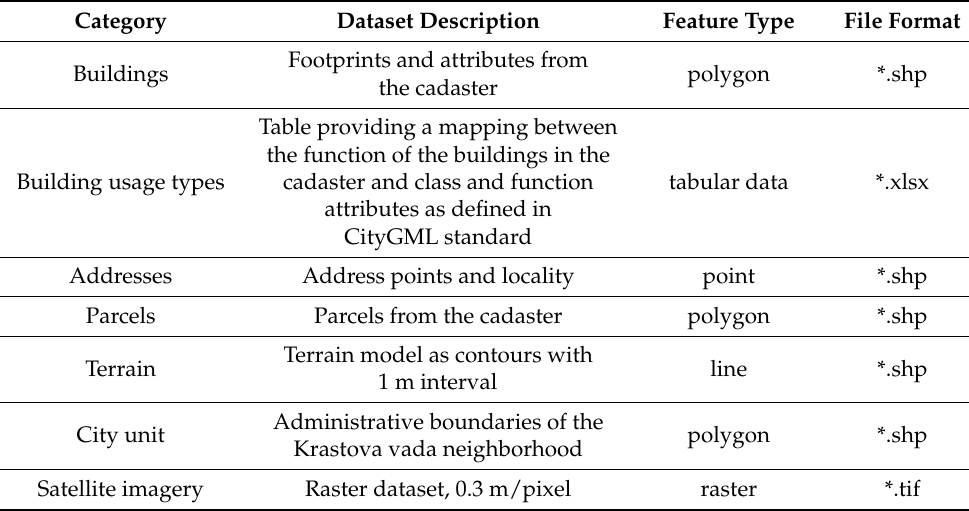
Table 2. Data sources for the implementation of a 3D city model in Sofia, Bulgaria.